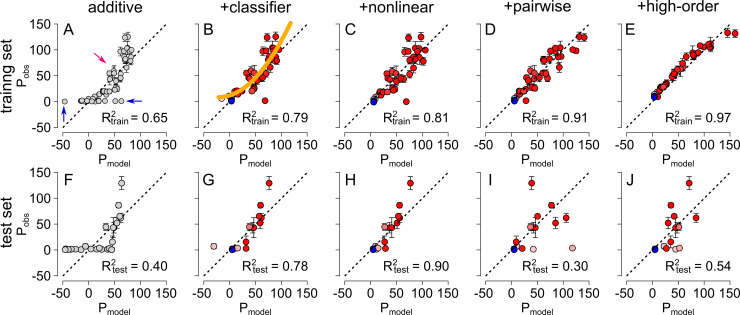
Models can be trained on measured phenotypes to predict uncharacterized phenotypes.The panels show the observed phenotype (Pobs) versus the predicted phenotype (Pmodel) for different input data and models. The vertical error bars represent experimental uncertainty (95% confidence interval on the mean) in the observed phenotypes. The resulting R2 value is shown within each plot and the dashed line depicts a 1:1 relationship (i.e. perfect agreement). The top row (panels A-E) shows the quality of fit for the training dataset (the 52 published phenotypes [24]) and the bottom row (panels F-J) shows the quality of fit for the test dataset (24 newly-measured phenotypes). The models are arranged from left to right in order of increasing sophistication: additive (A,F), additive+classifier (B,G), additive+classifier+nonlinear (C,H), additive+classifier+nonlinear+pairwise epistasis (D,I), and additive+classifier+nonlinear+all epistatic orders (E,J). Symbol colors denote the probability a genotype belongs to either the CQ-transporter (red) or the non-CQ-transporter (blue) class. Gray symbols (panels A, F) show the additive model, prior to the application of a classifier. The blue arrows in panel A indicate data points for which the observed phenotype is zero and the predicted phenotype is nonzero. The red arrow indicates data points for which the observed phenotype is nonzero. The yellow line in panel B shows the spline fit to the data.